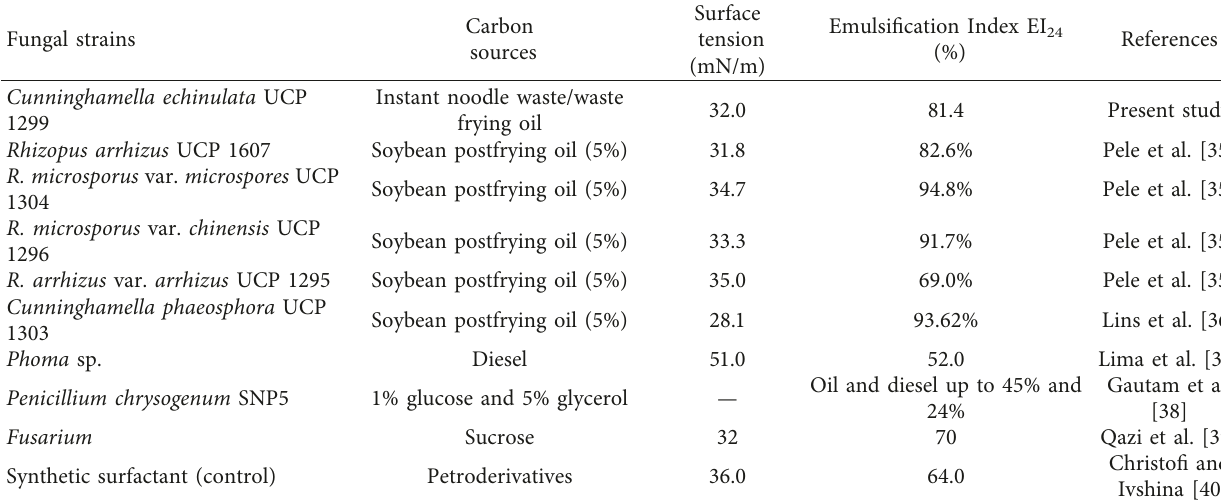
Table 3: Comparison of biosurfactant production by filamentous fungi using different substrates with Cunninghamella echinulata evaluating the surface tension (ST) and Emulsification Index (EI 24 ) in this study. Fungal